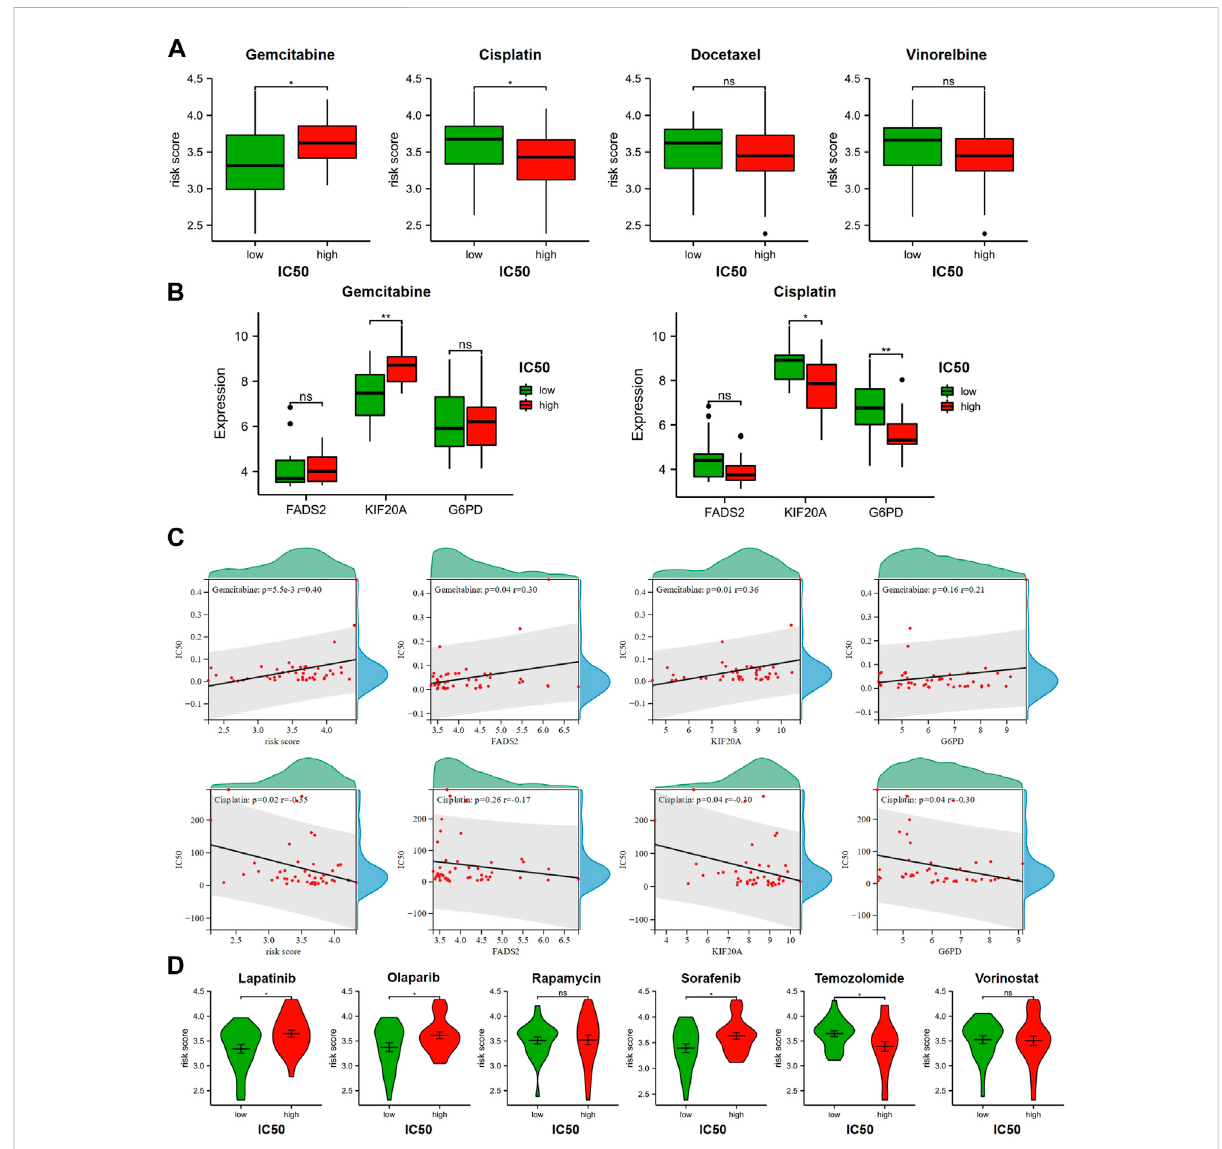
FIGURE 5 Relationship between GRFRM risk score and drug sensitivity. (A) Correlation analysis of IC50 and risk scores for GEM and chemotherapeutic agents commonly combined with GEM for LUAD. (B) Comparison of the expression levels of three prognostic genes in GEM and Cisplatin high and low IC50 groups, respectively. (C) Spearman coef fi cients were used for correlation analysis of drug IC50 and risk scores, as well as correlation analysis of drug IC50 and expression levels of three candidate genes. (D) Drug sensitivity of 4 FINs available for LUAD treatment was